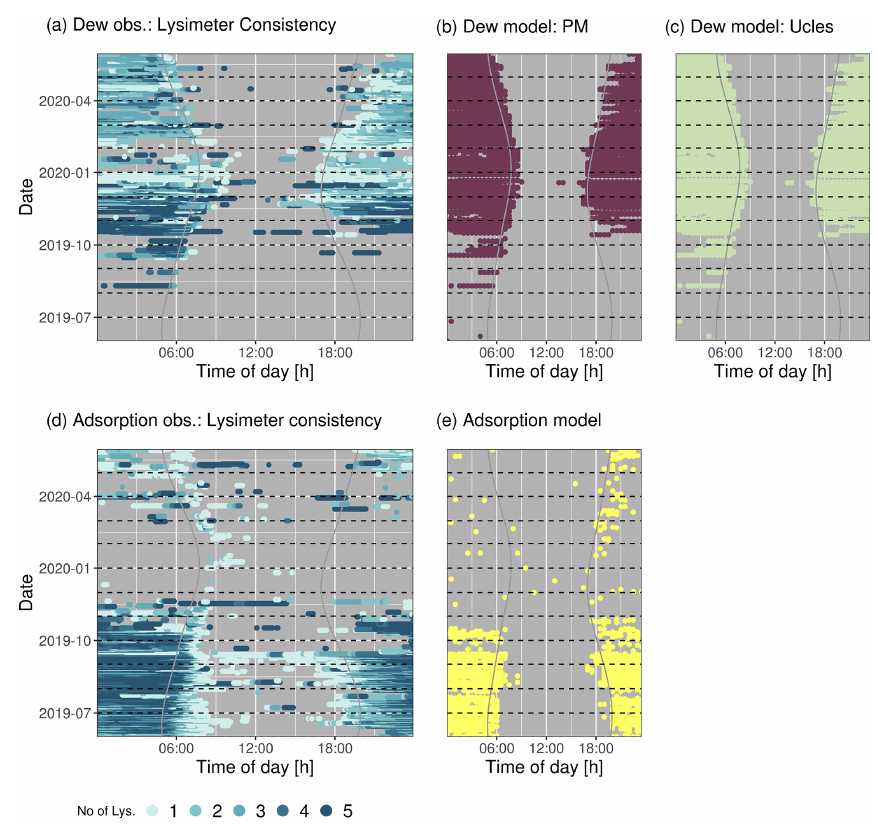
Figure 6. Diel and seasonal dynamics of the consistency of inferred (a) dew and (d) adsorption across all lysimeters. The modeled occurrence is presented for dew from (b) the Penman–Monteith model (PM) and (c) equilibrium evaporation model and for adsorption using (e) the aerodynamic diffusion equation. Solid lines mark sunrise and sunset, as determined by the geographic coordinates of the site.